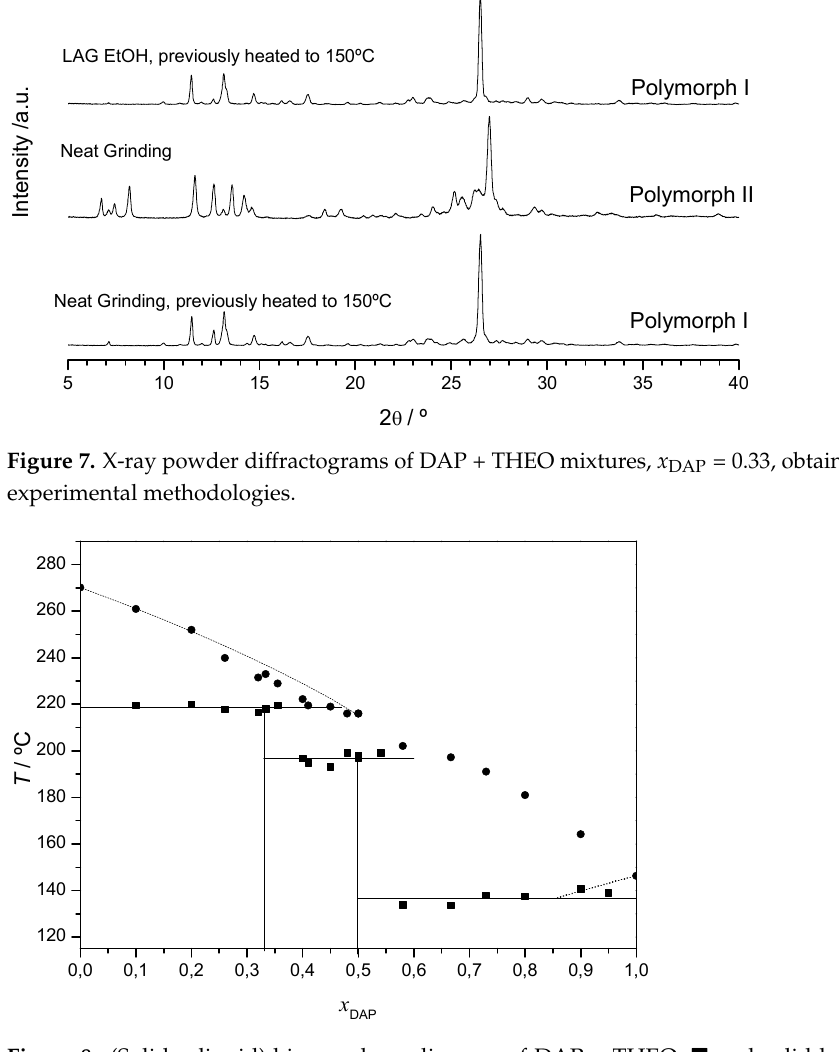
Figure 8. (Solid + liquid) binary phase diagram of DAP + THEO: ■ and solid horizontal line—experimental solidus; ●—experimental liquidus; vertical line—co-crystal composition. Dotted lines obtained using eq. (1).